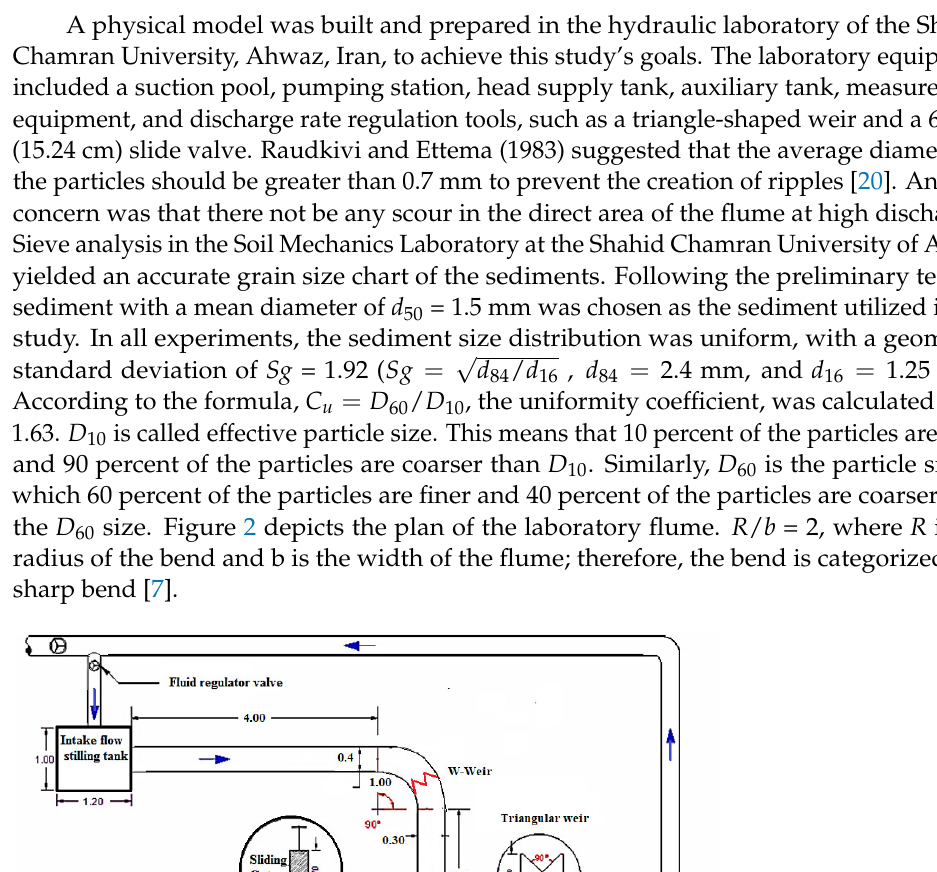
Figure 1. ( a ) W − Weir in the river bend and ( b ) the W − Weir shape [18].